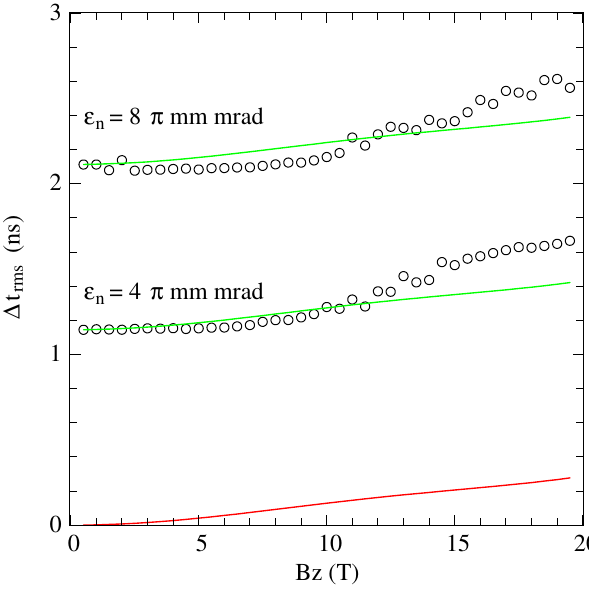
FIG. 7. Comparison of the simulated (circles) and analytic calculation (green curve) of (cid:1) t rms for beams with finite extent, axial velocity tilt, and normalized edge emittances of 4 and 8 (cid:4) mm mrad . In each case, the green curve is the analytic (cid:1) t with the (cid:1) t rms from the simulation with small solenoid field added. The analytic (cid:1) t rms does not include either the tilt or the thermal spread. The solenoid is the case that is mostly